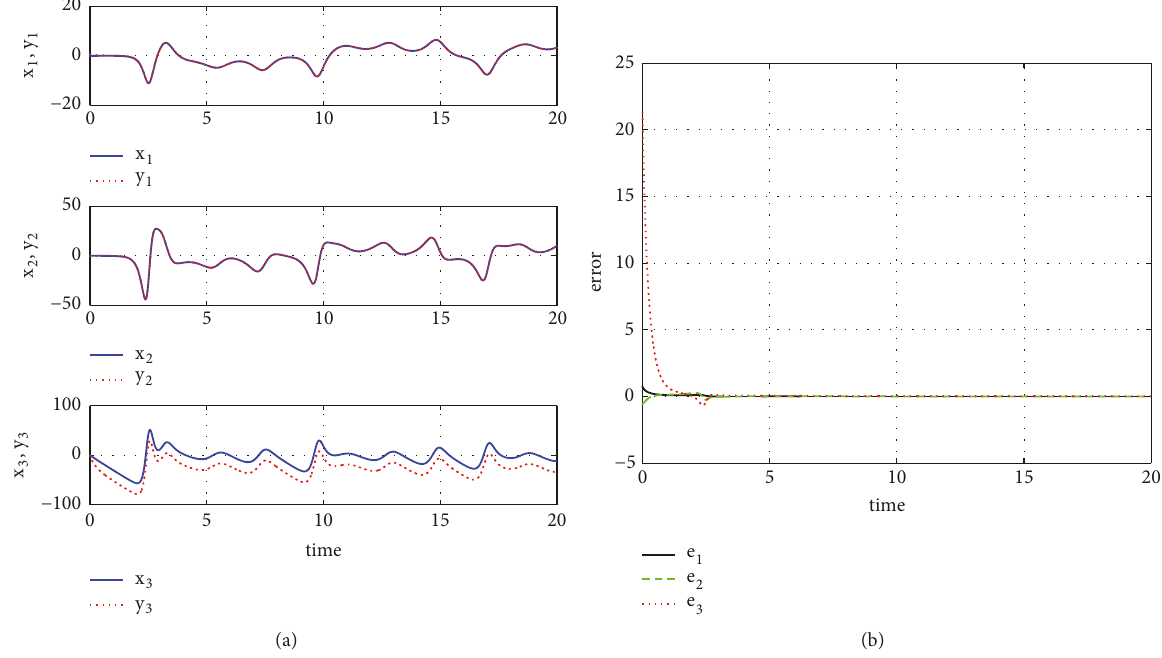
Figure 11: Partial phase synchronization with k 2 =10, k 3 =4, and c =0.5: (a) time response; (b) synchronization